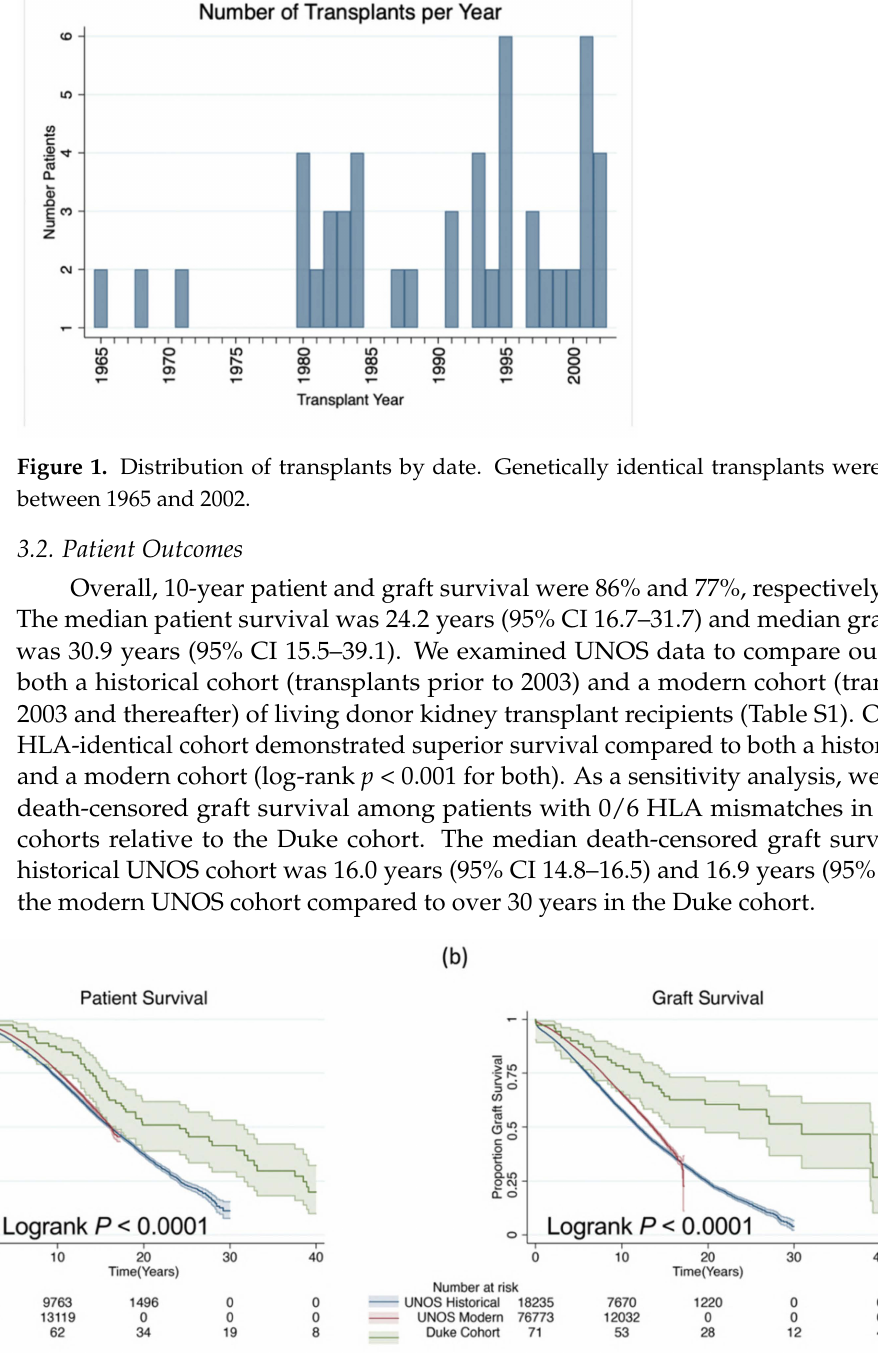
Figure 2. Patient and graft survival. Patient- ( a ) and death-censored graft ( b ) survival are depicted using the Kaplan–Meier method. Shading is 95%